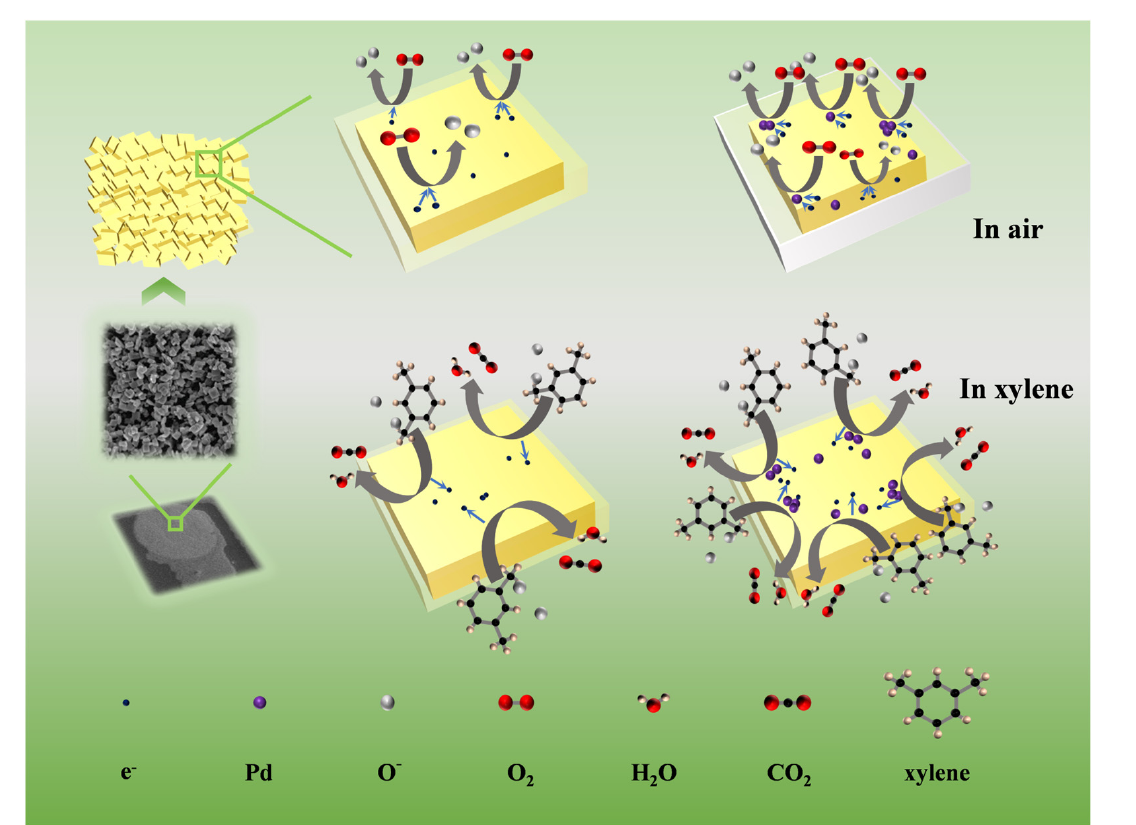
Figure 12. Schematic of the sensing mechanism of pristine and Pd-modified WO 3 .